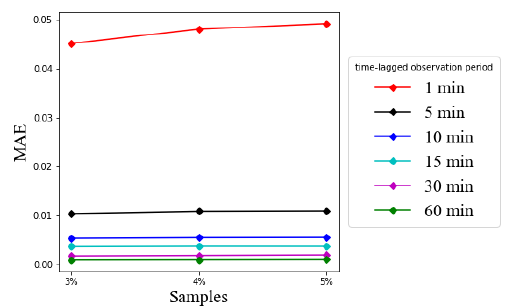
Figure 19. MAE of sample sizes 3% to 5% with varied time-lagged observation period.